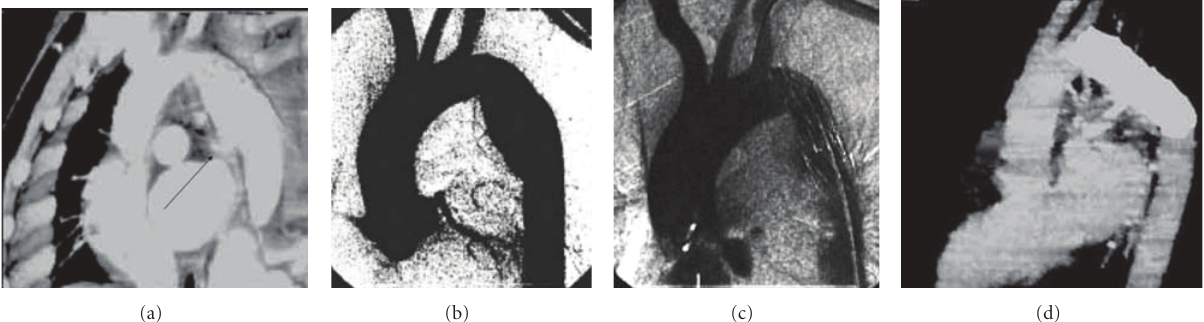
Figure 1: (a) MRI showing a spindle-shaped aneurysm at the beginning of the descending aorta with a suspected rupture in its inner wall (arrow); (b) DSA showing a fusiform aneurysm at the top of the descending aorta; (c) the lesion is properly treated by an endograft; (d) follow-up MRI showing a well-deployed endograft two years after deployment.